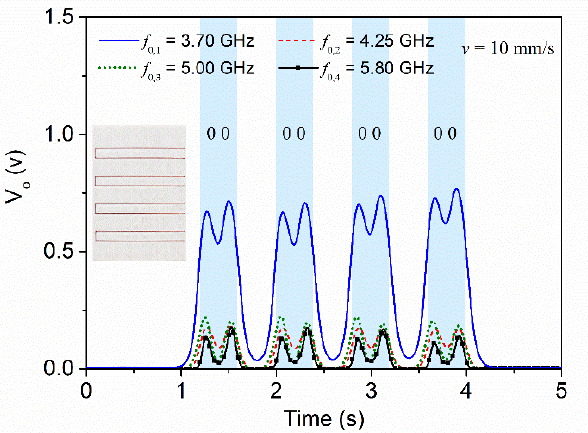
Figure 11. Envelope functions for the four frequencies corresponding to the (second) resonances of the four C-shaped resonators, for the tag depicted in the inset. Reprinted with permission from [65]. Figure 12 depicts a different combination of resonators and the corresponding en- velope functions where, again, there is a perfect correlation between the peaks and the resonant elements.